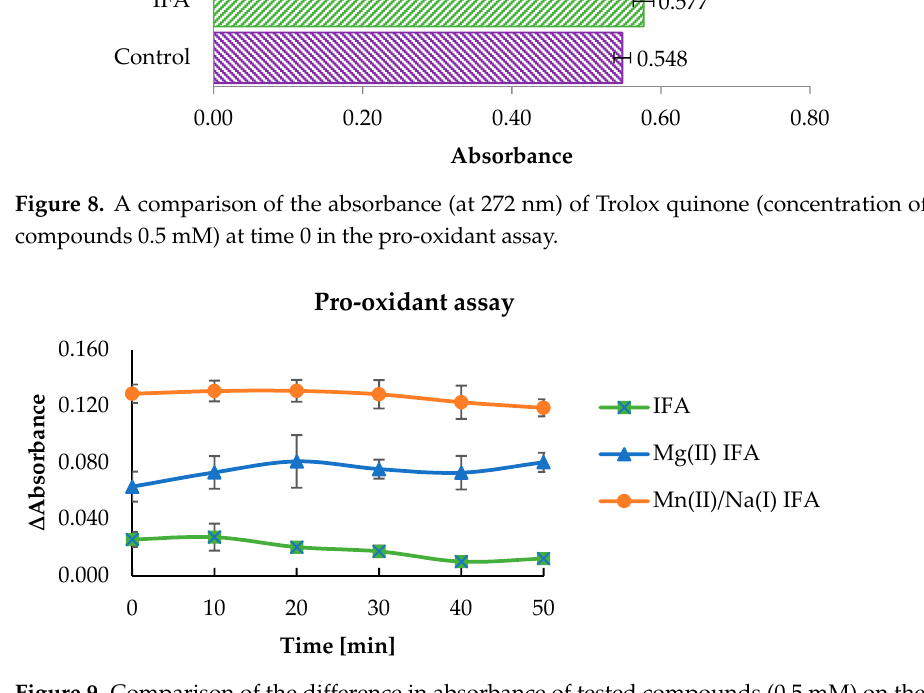
Figure 9. Comparison of the difference in absorbance of tested compounds (0.5 mM) on the rate of the Trolox oxidation reaction measured every 10 min for 50 min.